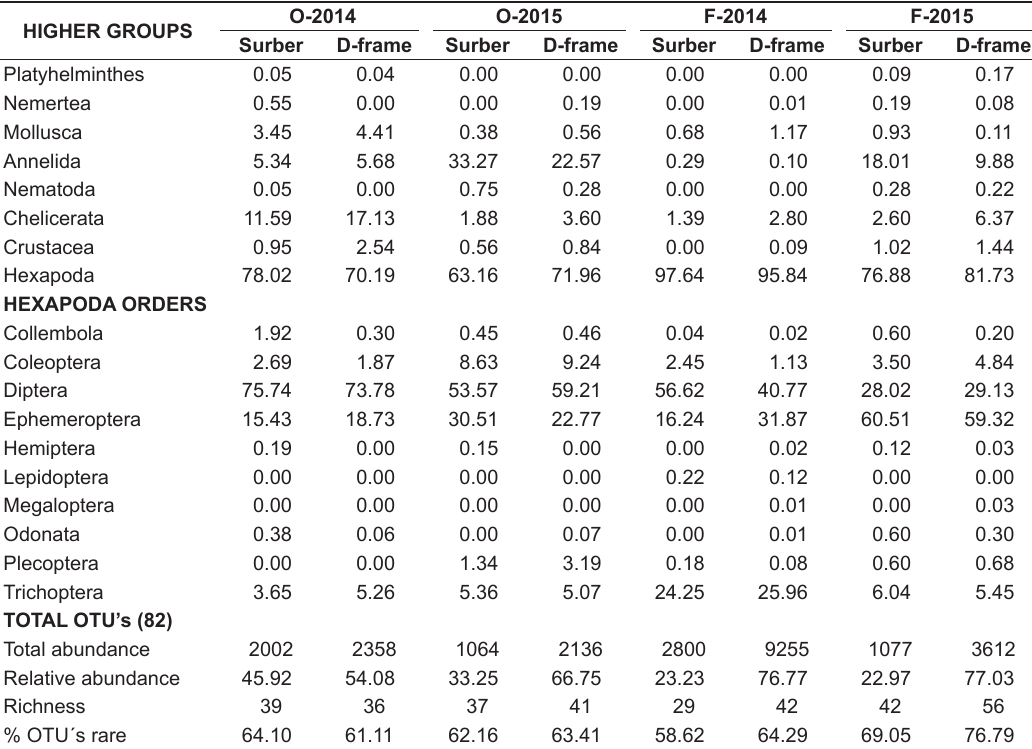
Table 1. Relative abundance (%) of benthic invertebrates sampled in two reaches of Itaúna stream (O- open, F- forest) in 2014 and 2015, using two samplers (Surber and D-frame net). Data presented for the higher taxonomic groups, for the Hexapoda orders and for the total OTU’s sampled (rare = abundance